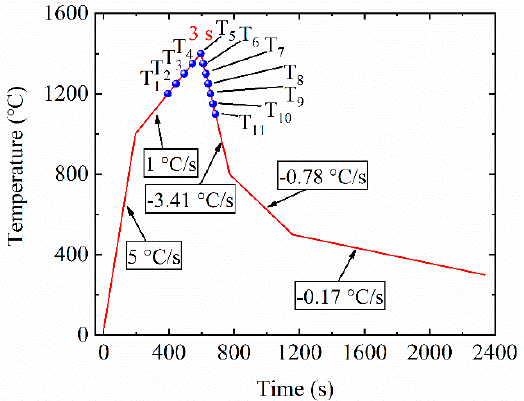
Figure 1. Thermal cycle of in situ observation experiment simulated heat-affected zone (HAZ) during high-heat-input welding by HT-LSCM.